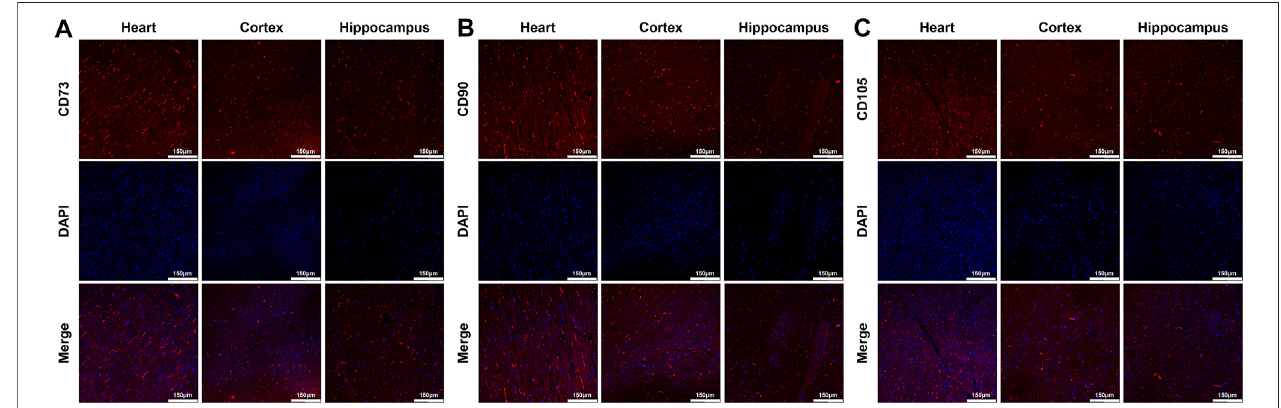
FIGURE 4 | Distribution of MSCs in the heart, cortex and hippocampus (A) – (C) Representative photomicrographs of immuno fl uorescence staining of MSCs ’ surface markers CD73, CD90 and CD105 ( × 200magni fi cation). MSC, mesenchymal stem cell.